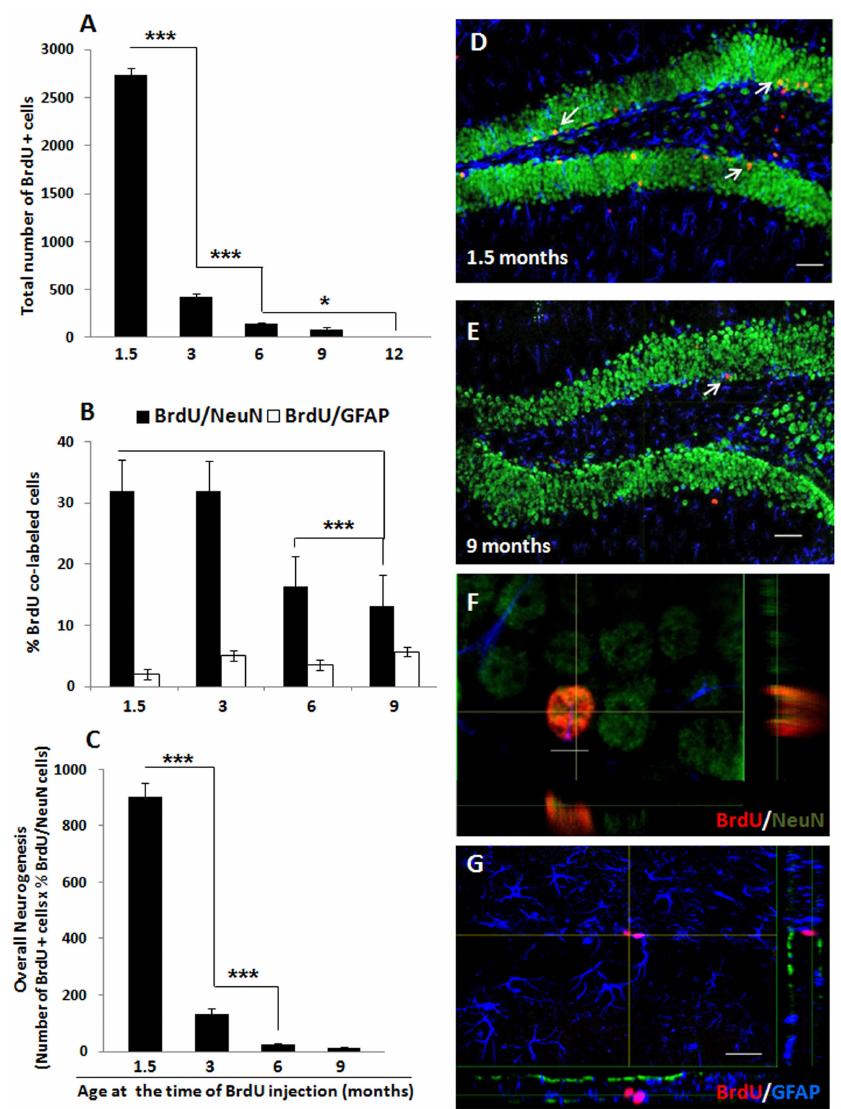
Figure 4. Ageing results in an abrupt decrease in overall neurogenesis in the mouse DG. C57BL/6J male mice with 1.5, 3, 6, 9, and 12 months of age received BrdU injections (200 mg/kg i.p.) every 12 hours for 3 consecutive days and were sacrificed by transcardial perfusion 42 days later, to allow enough time for differentiation of the proliferating cells that incorporated BrdU. The brains were removed, processed for BrdU/NeuN/GFAP fluorescence immunohistochemistry, and visualized by confocal microscopy. (A) A significant effect of age was found regarding the number of BrdU-labeled cells present in the DG 42 days after the last BrdU administration. * p < 0.05 between 6 and 12 months and between 9 and 12 months, *** p < 0.001 between 1.5 and 3 months and between 3 and 6 months. (B) The percentage of newly born cells (that incorporated BrdU) that co-expressed the mature neuronal marker NeuN was also significantly reduced by age while the percentage of BrdU-positive cells that co-expressed the glial marker GFAP remained unaffected by age. *** p < 0.001 between 1.5 and 6 or 9 months and between 3 and 6 or 9 months. (C) An estimation of overall neurogenesis based on the total number of BrdU-positive cells that survived the 42-day period multiplied by the proportion of BrdU-positive cells that acquired a mature neuronal phenotype indicates an age-induced significant and abrupt decrease in the overall number of new neurons. *** p < 0.001 between 1.5 and 3 months and between 3 and 6 months. (D, E) Representative confocal images of the DG showing mature granule neurons labeled with NeuN (green) and BrdU-positive cells (red) that survived over 42 days in 1.5- (D) and 9- (E) month old mice. Arrow in (E) indicates a BrdU/NeuN double-labeled cell in the DG of a 9 month-old mouse. (F, G) Orthogonal representations of immunopositive cells for (F) BrdU (red) / NeuN (green) or (G) BrdU (red) / GFAP (blue). White arrows indicate BrdU-immunopositive cells in the DG of 1.5- (D) and 9- (E) month old mice. Data are presented as means ± SEM. See text for additional statistical details. Scale bars (D, E, G) = 50 µm; scale bar (F) = 5 µm. doi: 10.1371/journal.pone.0075125.g004 PLOS ONE |